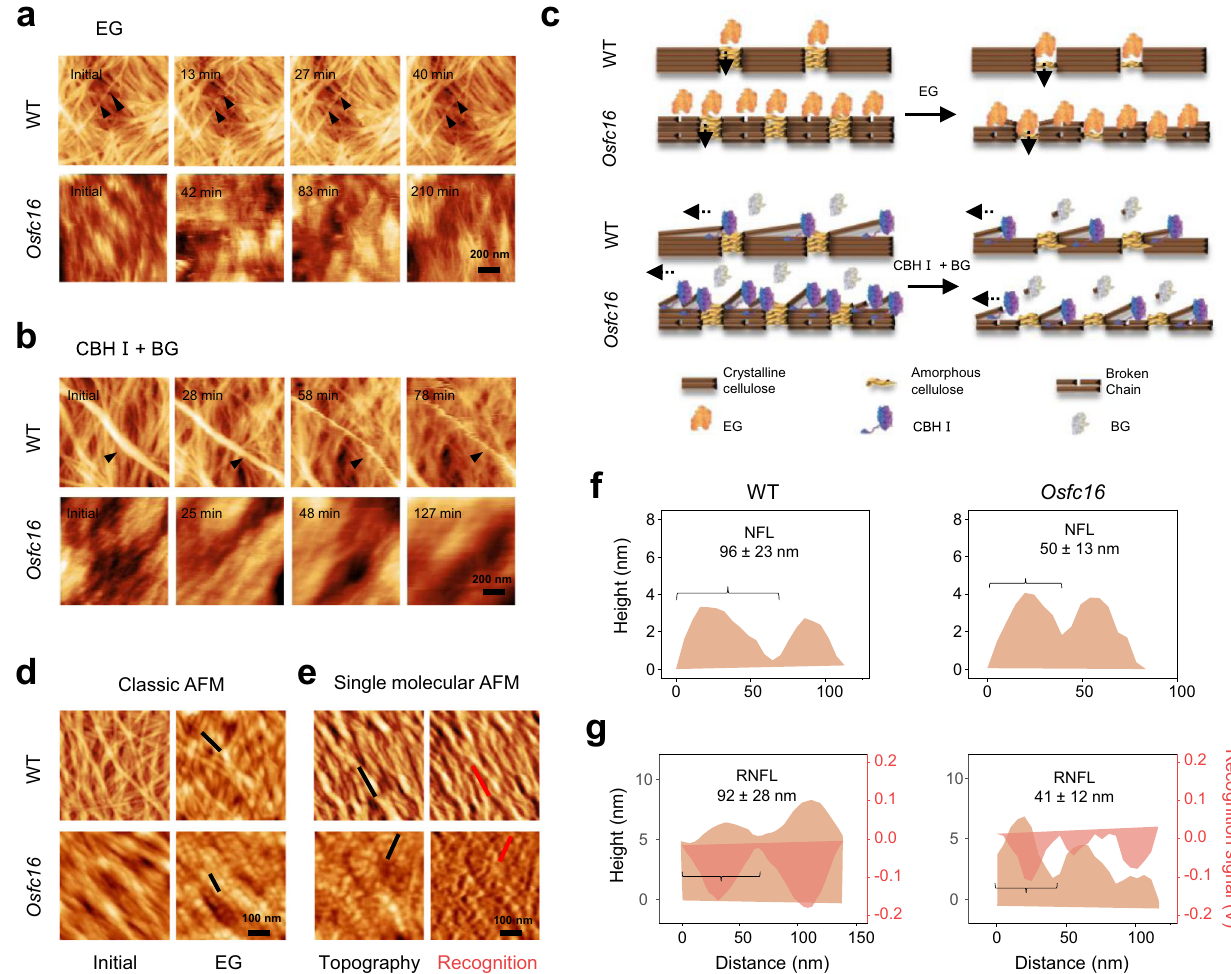
Fig. 4 | In situ enzymatic hydrolyses of CMFs into CNFs by real-time and recognition AFM observation in WT and Osfc16 mutant. a , b AFM topography images of CMFs(8% NaClO 2 extraction) after time-course enzymatichydrolyses by EG or mixed-cellulases (CBHI+BG), preparing samples for ( d , e ). c Schematic illustration of distinct catalysis modes for cellulose hydrolyses with EG and mixed- cellulases (CBHI+BG), respectively. d , e Classic and single-molecular AFM images for nano fi bers from the samples in a . f , g Cross pro fi le corresponding for lines in